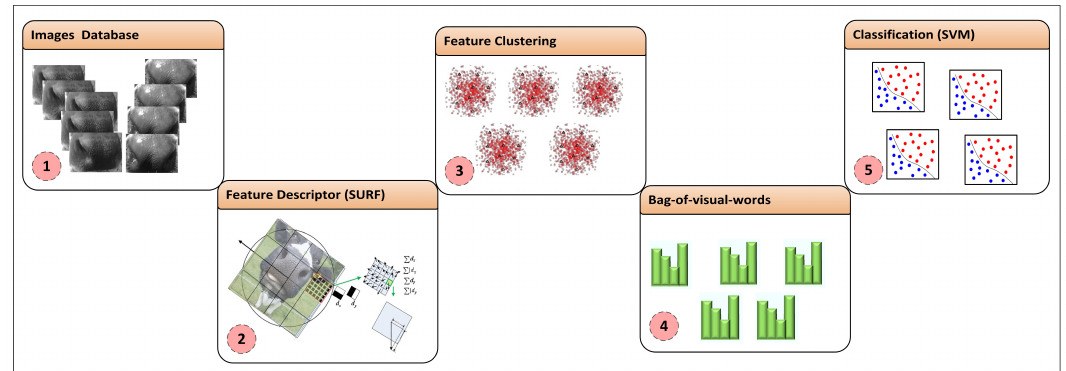
Figure 2. Outline of the main components of the bag-of-visual-words (BoVW)-based cattle identification system. The input muzzle print image database, feature extraction, feature clustering, bag-of-visual-words histograms and classification steps are highlighted as the main identification system components.